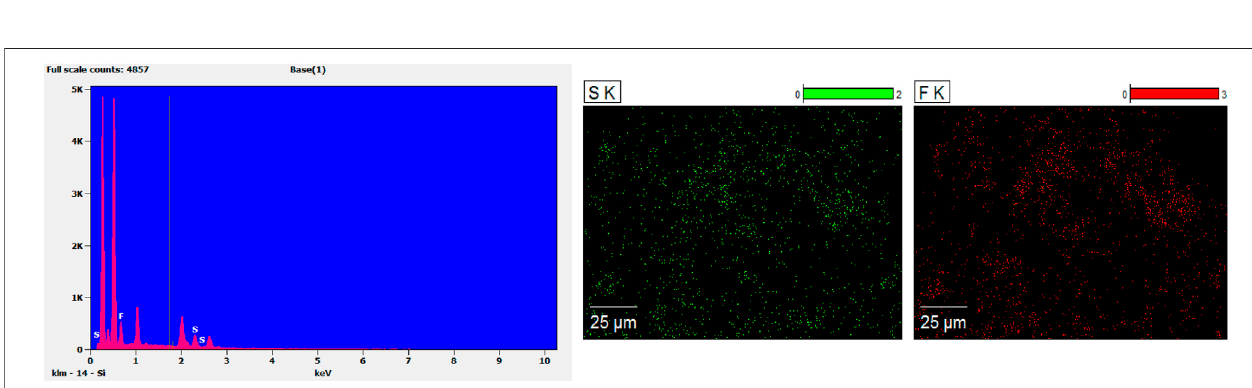
Frontiers in Bioengineering and Biotechnology |